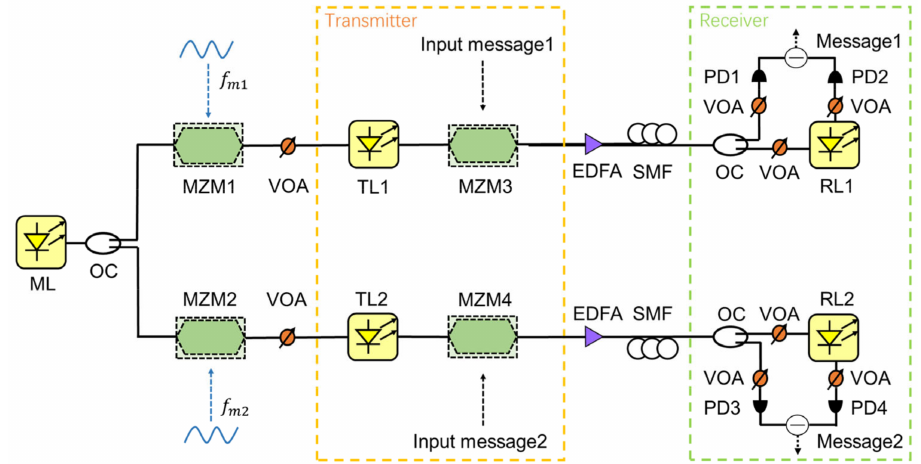
Figure 1. Schematic of dual-channel chaotic communication system subject to IM optical injec- tion. ML, master laser; TL, transmitter lasers; RL, receiver lasers; MZM, Mach–Zehnder modula- tors; OC, optical coupler; VOA, variable optical attenuators; EDFA, erbium doped fiber amplifier; PD,